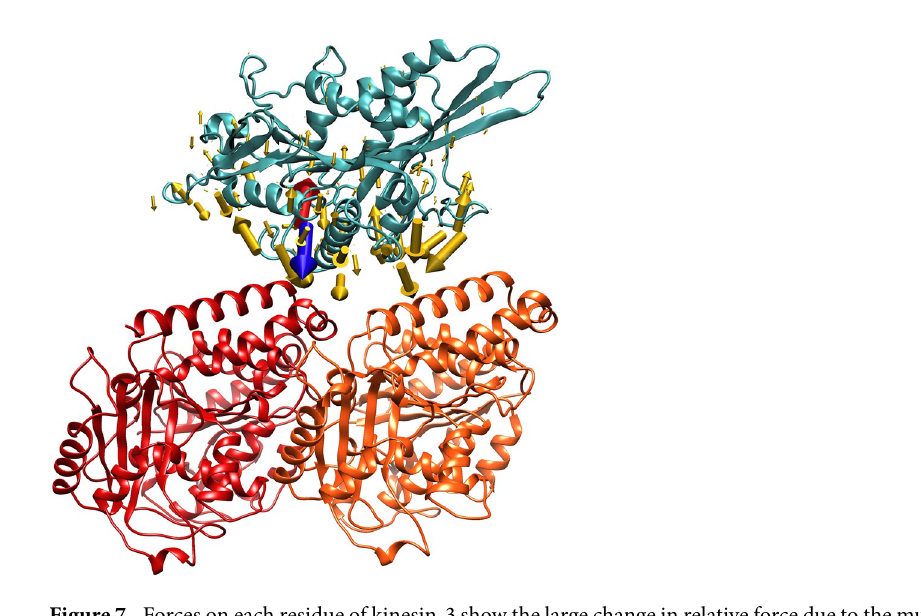
Figure 7. Forces on each residue of kinesin-3 show the large change in relative force due to the mutation. Kinesin-3 family member KIF1A (light blue) with the E253K mutation is shown bound to a tubulin dimer with α -tubulin (red) on the left side and β -tubulin (orange) on the right side. Most electrostatic forces (yellow arrows) on each residue of the kinesin-3 remain unchanged, but the force on residue 253 changes with the mutation, with both the force on wild type (red arrow) and the force on the mutant (blue arrow)